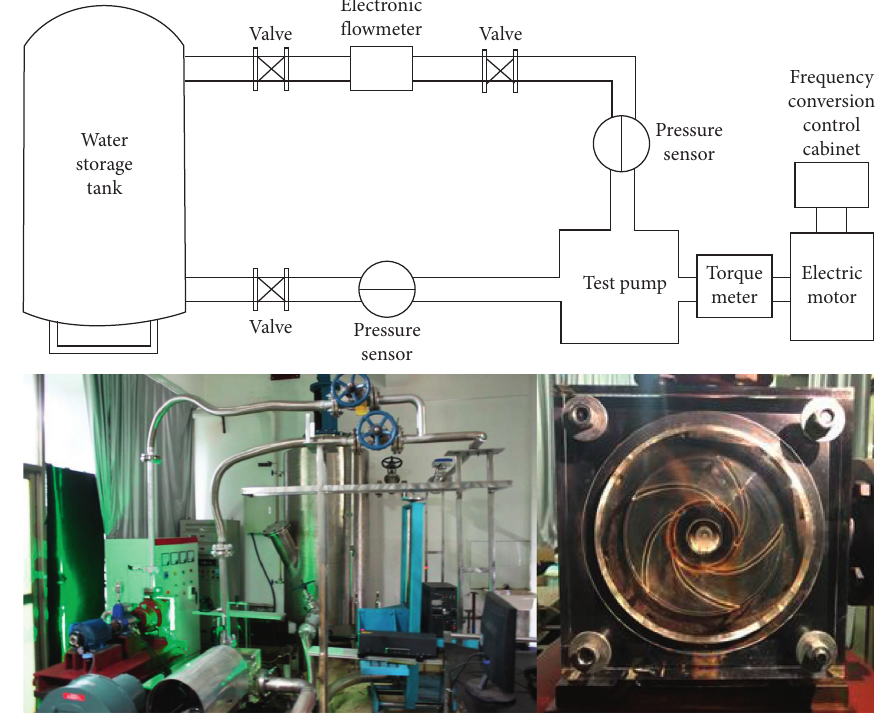
Figure 3: Test rig for